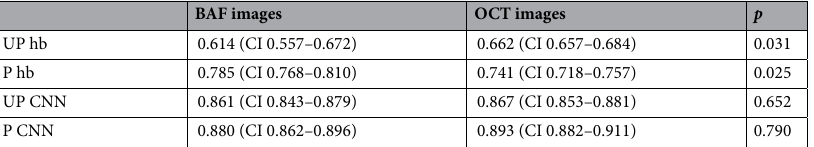
Table 4. Comparison of classification accuracy using either BAF or OCT images for each of the 4 described methods. The analysis responds to the question “Does UPhb/Phb/UP CNN/P CNN perform better when applied on BAF or OCT images?”. BAF blue autofluorescence, CNN convolutional neural network, OCT optical coherence tomography, P CNN CNN classification of unprocessed images, P hb human-based classification of processed images, UP CNN CNN classification of unprocessed images, UP hb human-based classification of unprocessed images.